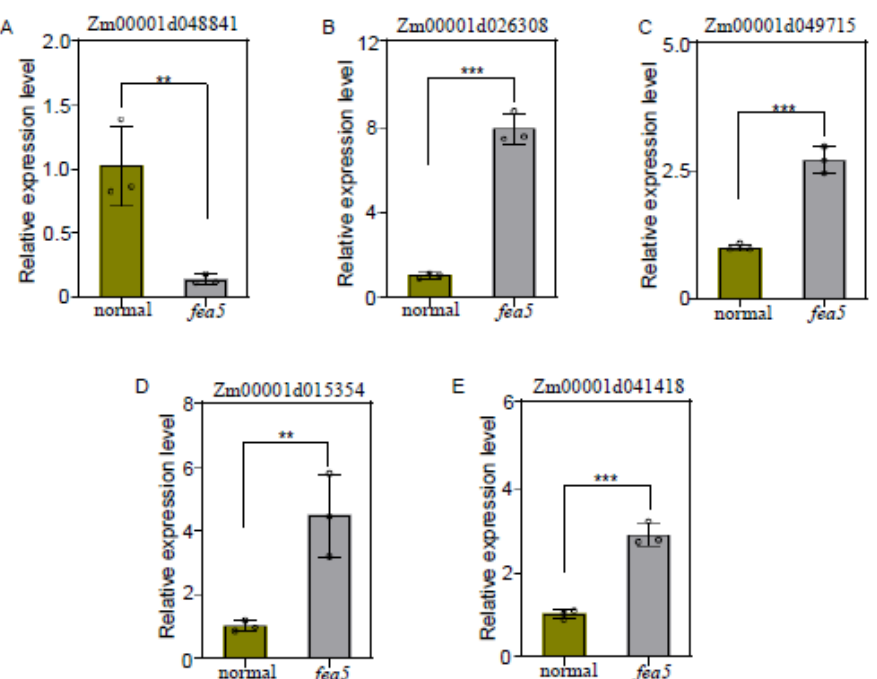
Figure 7. Verification of selected candidate genes in fea5 and the normal ears by RT-qPCR. The transcript levels of Zm00001d048841 and IAA-responsive genes Zm00001d026308 , Zm00001d049715 , Zm00001d015354 , and Zm00001d041418 were verified by RT-qPCR with three replicates per gene. Values represent means ± SD. Asterisks indicate significant differences: ** p < 0.01 and *** p < 0.001. Int. J. Mol. Sci. 2022 , 23 , x FOR PEER REVIEW 2.8. Natural Variations in Zm00001d048841 Are Associated with KRN in Maize